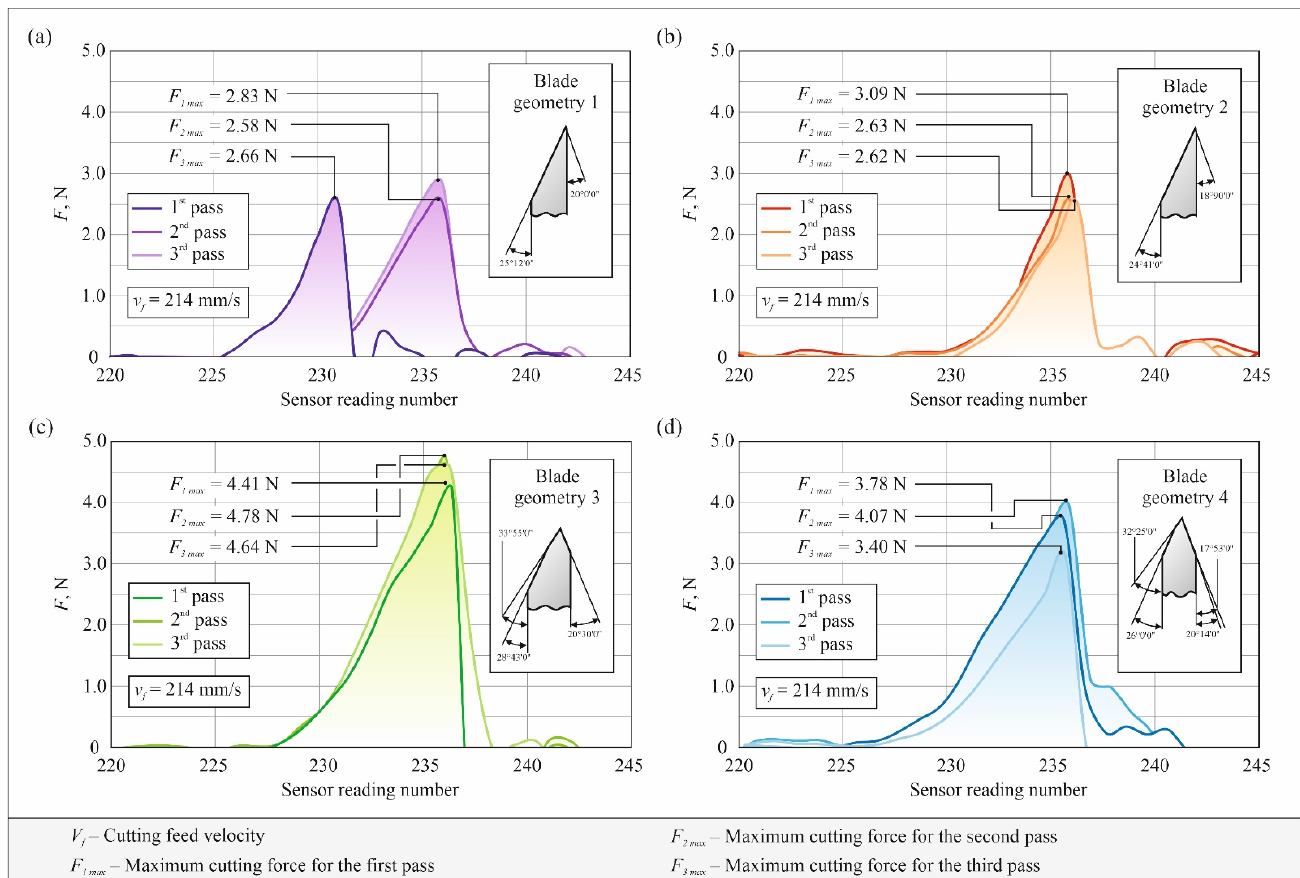
Figure 6. Collection of experimental results of cutting force F of knives with four different transverse blade outlines: ( a ) results of three repetitions for the knife with geometry 1; ( b ) results of three repetitions for the knife with geometry 2; ( c ) results of three repetitions for the knife with geometry 3; ( d ) results of three repetitions for the knife with geometry